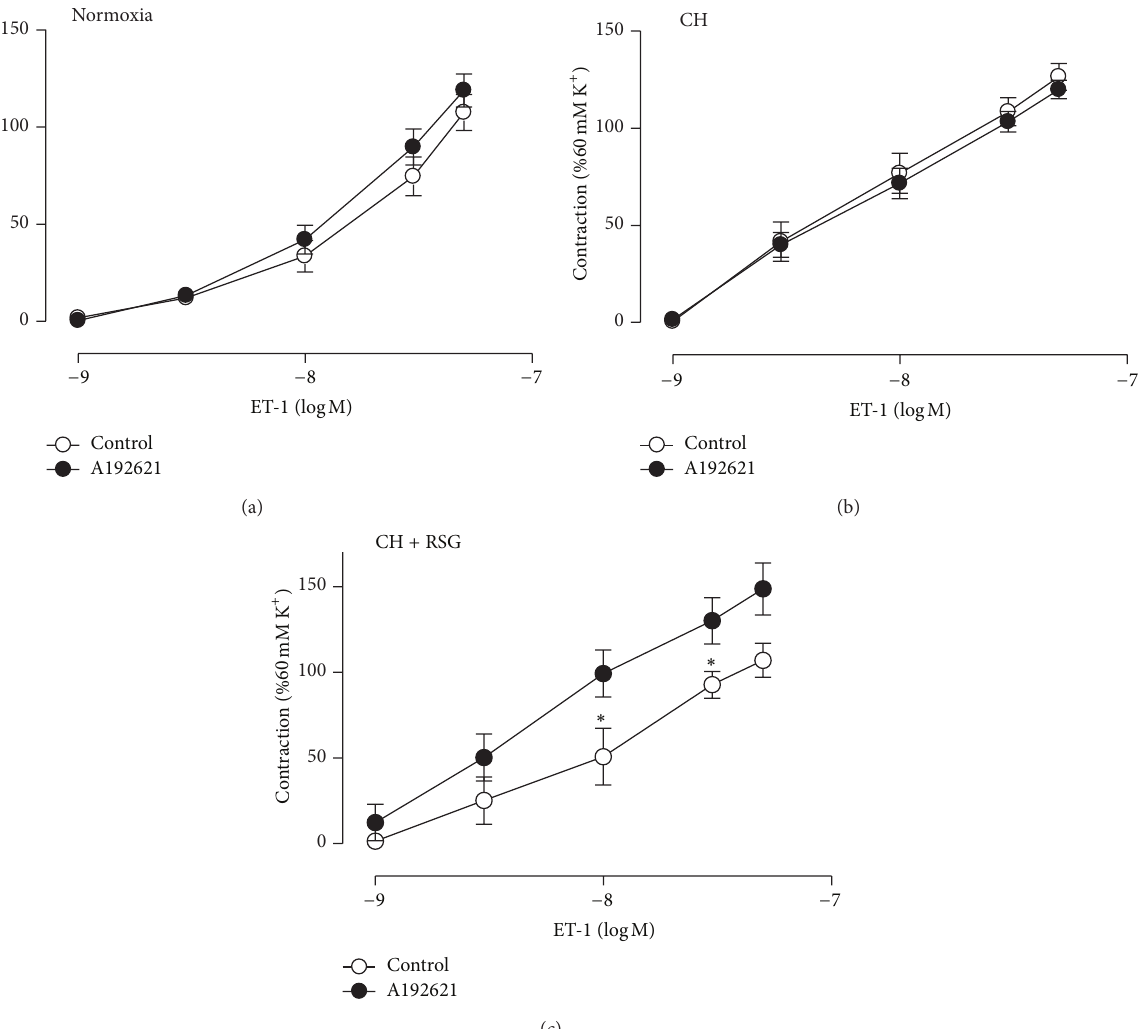
R antagonist. Concentration-dependent B